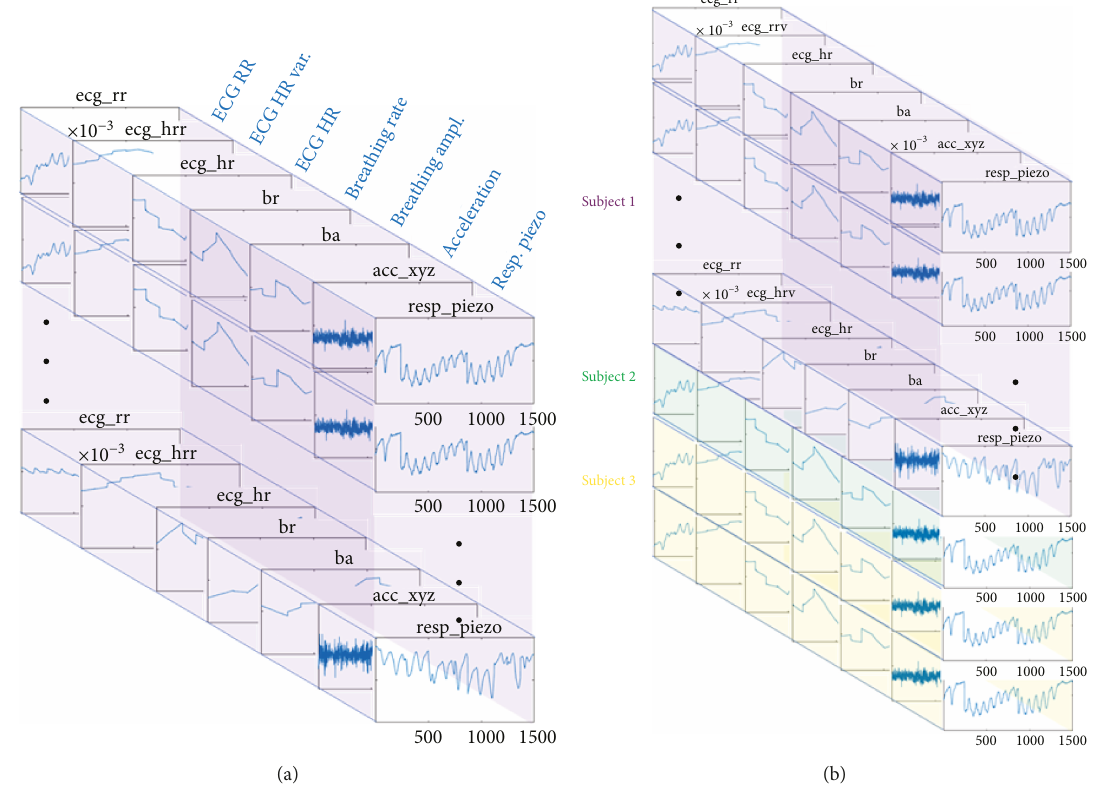
Figure 3: 3D-tensor for one subject (a) and 3D-tensor of all subjects (b). Table 1: Number of instances and percentages of bags (subjects) and instances (time windows) per class. Class Nr. of bags Nr. of instances Perc. of